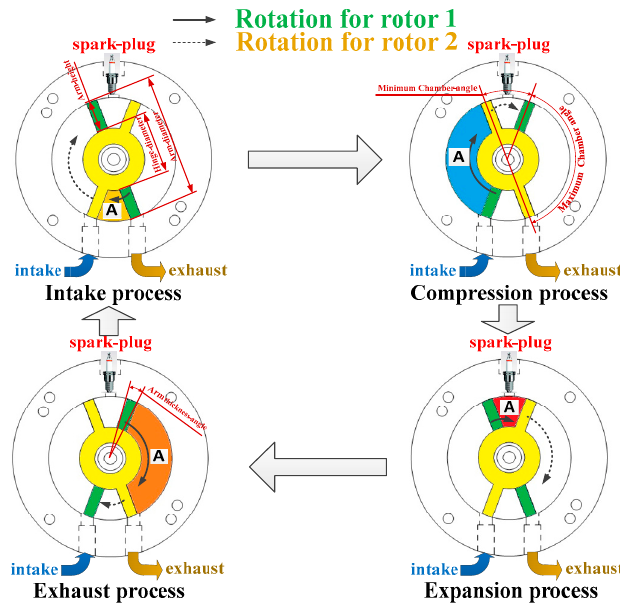
Figure 2. Operation process of the micro swing rotor engine.